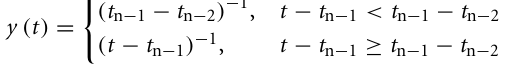
FIGURE 2 | Cumulative variance explained by the rank-ordered principal components . Each point represents the mean across all recordings each monkey. Error bars indicate 1